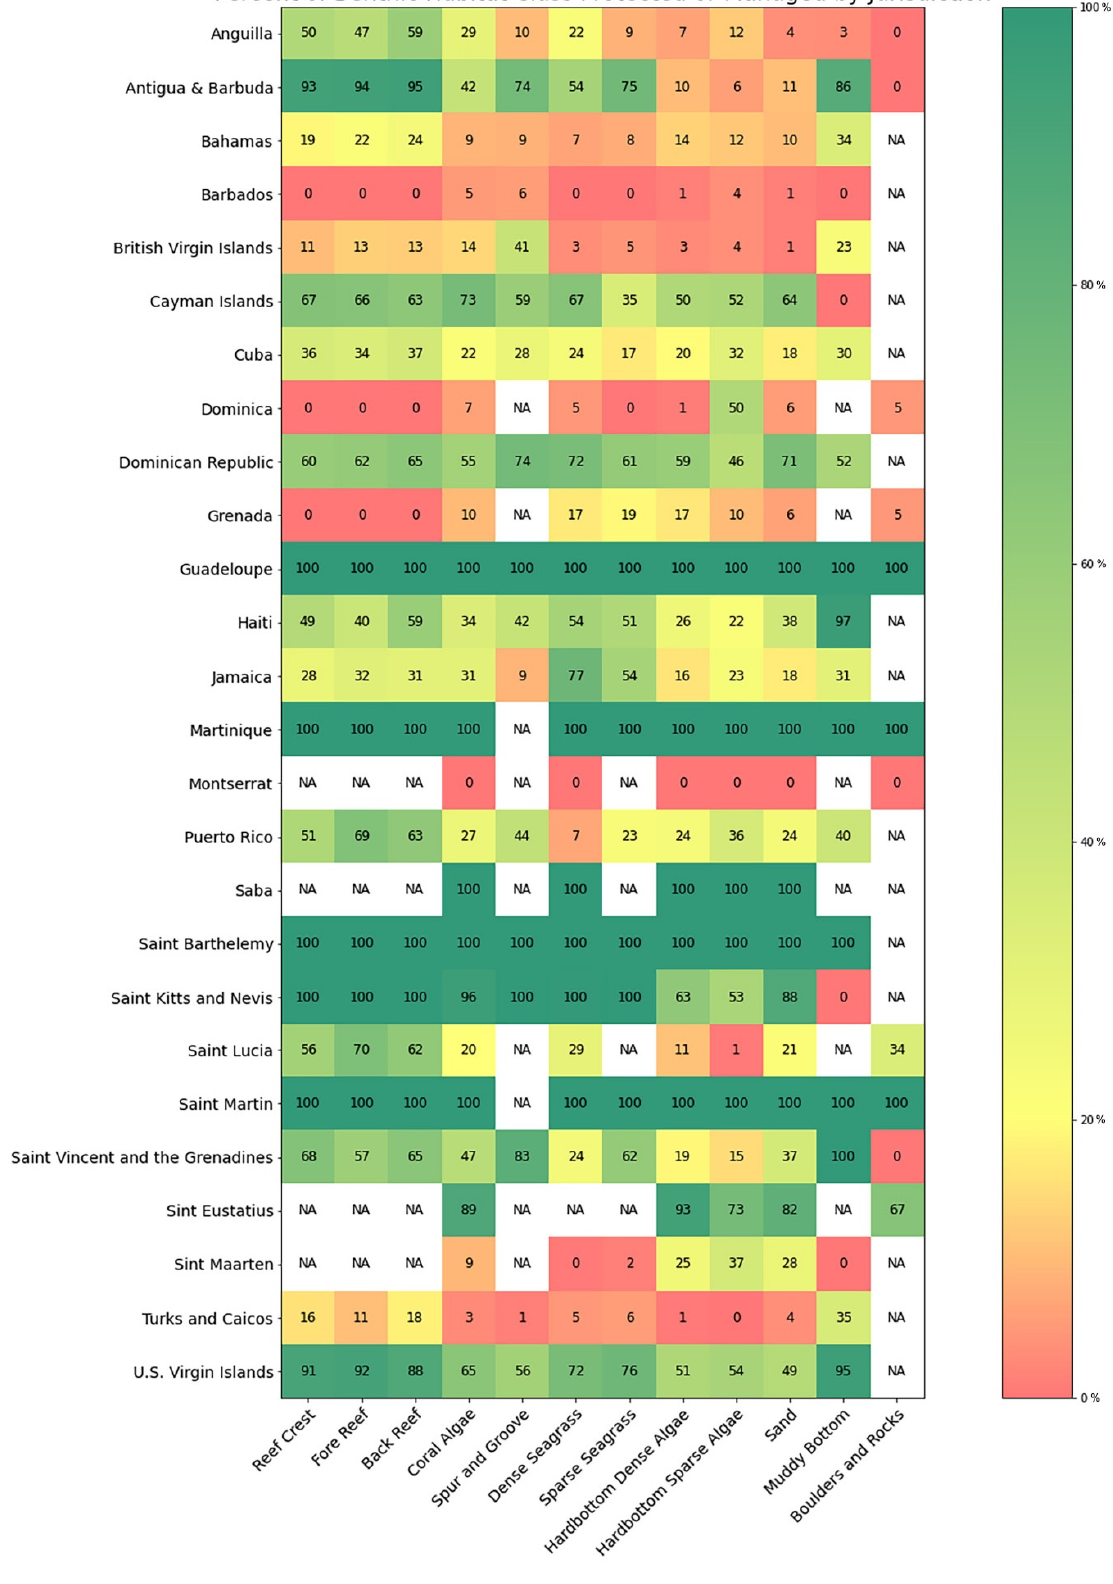
Figure 11. Percentage of benthic habitat class protected or managed by jurisdiction, based on The Nature Conservancy’s declared Caribbean marine protected or managed area database.